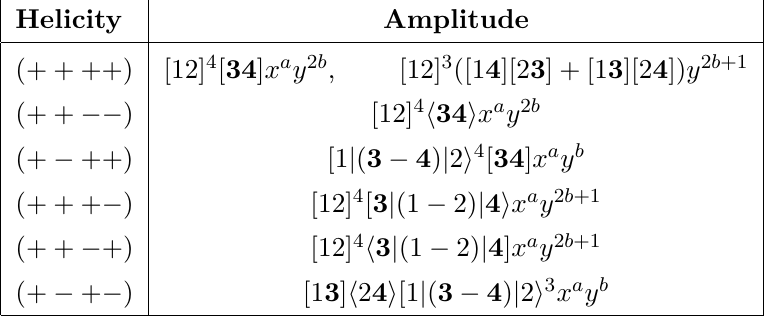
Table 2 . The amplitude basis for gravitational tidal effects. The helicity labels are ordered as ( g 1 g 2 ψ 3 ψ 4 ) . The three first rows are the amplitude basis for odd mass dimensions, while the three last rows are for even mass dimensions. Here a and b take integer values from 0 to ∞ . The amplitudes for opposite helicities can be obtained by exchanging angle and square